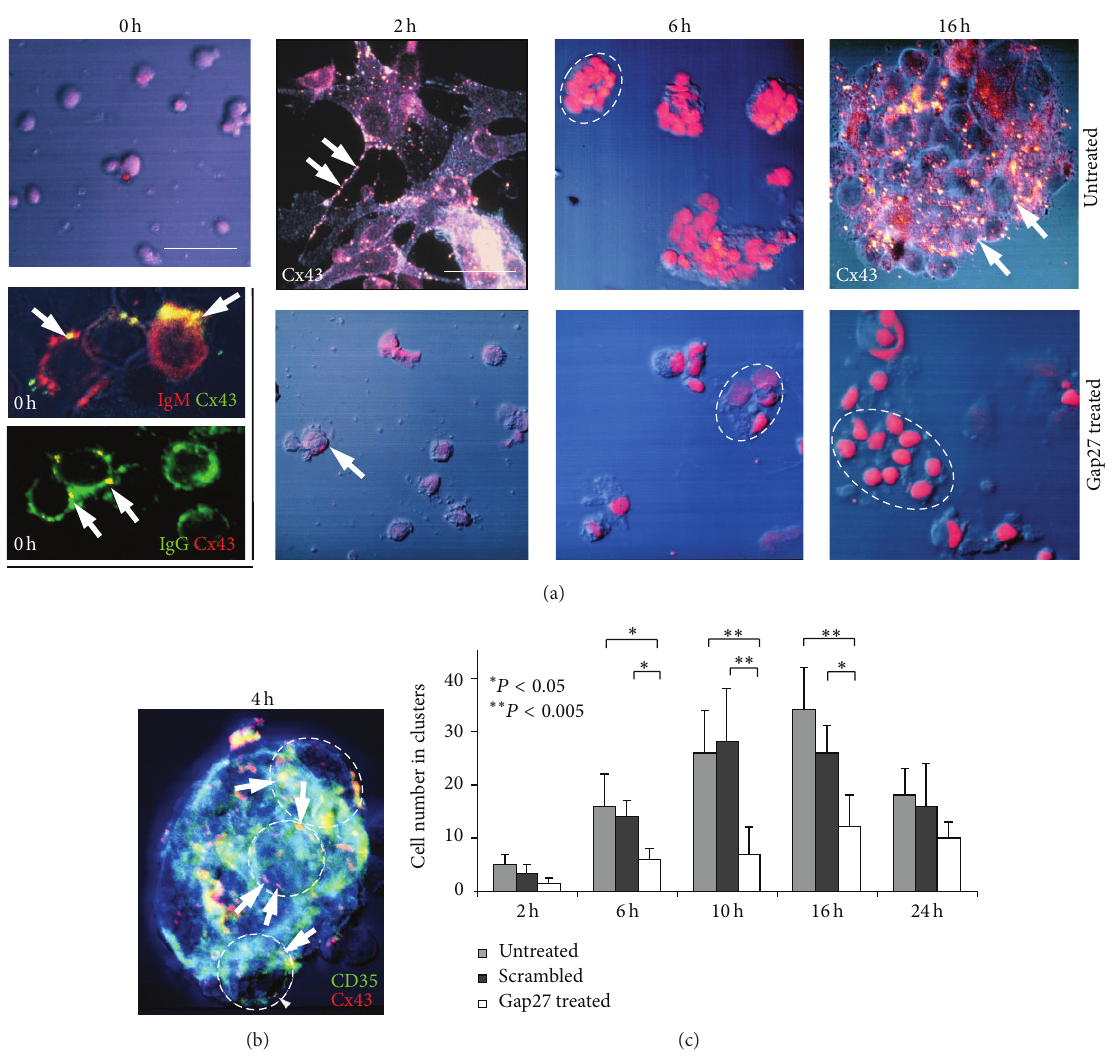
Figure 2: Treatment of low density cell fractions of reactive human tonsils in culture using 200 𝜇 M Gap27 connexin mimetic peptide. (a) At the start (0h) round cells are dispersed, some of them coexpressing Cx43 and either IgG or IgM (arrows). In control (untreated) cultures (1st row) at 2 h, FDC processes decorated with Cx43 (arrows) enmesh round B cells. By 6h clusters are formed of 10–15 FDC and B cells which grow up to ∼ 50 cells by 16h, with Cx43 plaques detected at the cell borders (arrows). In Gap27 treated cultures (2nd row) the cluster formation is seriously compromised resulting in cells of vacuolated cytoplasm (arrow) and shrunken nuclei. (b) A “healthy” FDC-B cell cluster of ∼ 8– 10 cells (some are encircled) with Cx43 particles (red) colocalizing in B cell membranes (yellow, arrows) with sheets of CD35 positive FDC (green), which envelop them. Immunofluorescence single and double labeling and Nomarski differential interference combined with nuclear staining using either 7-aminoactinomycin D ((a), red) or Hoescht ((b), blue). (c) Graph showing significantly ( ∗ 𝑃 < 0.05 ; ∗∗ 𝑃 < 0.005 ) reduced cell numbers within clusters after Gap27 treatment compared either to untreated or scrambled-probe treated cultures. Results in graphs show the mean and standard deviation of at least three independent experiments. Scale bar shows 50 𝜇 m, except in the untreated Cx43 labeled cultures (upper row) where it is 25 𝜇 m. In the left row middle panels it equals 15 𝜇 m and 10 𝜇 m in the bottom